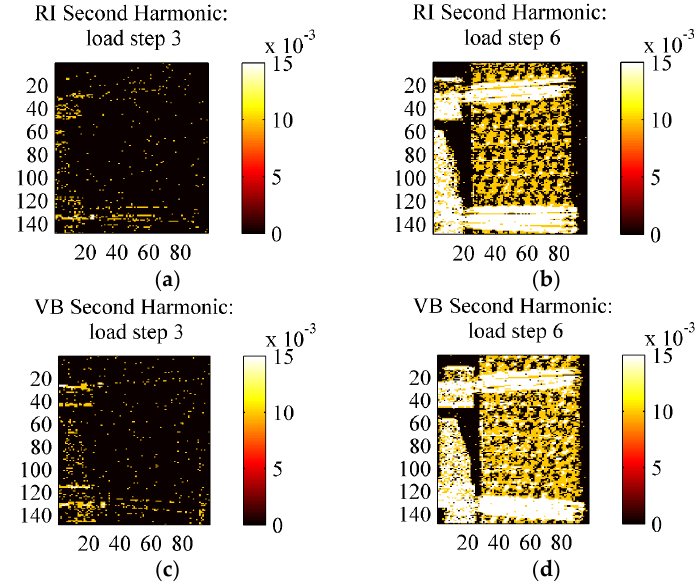
Figure 16. Comparison of second harmonic maps ( a ) RI sample under load step 3; ( b ) RI sample under load step 6; ( c ) VB sample under load step 3; ( d ) VB sample under load step 3.